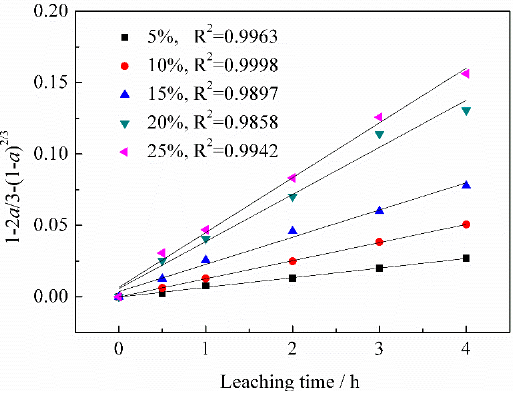
Figure 17. Fitting plots of 1 ´ 2 α /3 ´ (1 ´ α ) 2/3 versus leaching time t at different sulfuric acid concentrations.